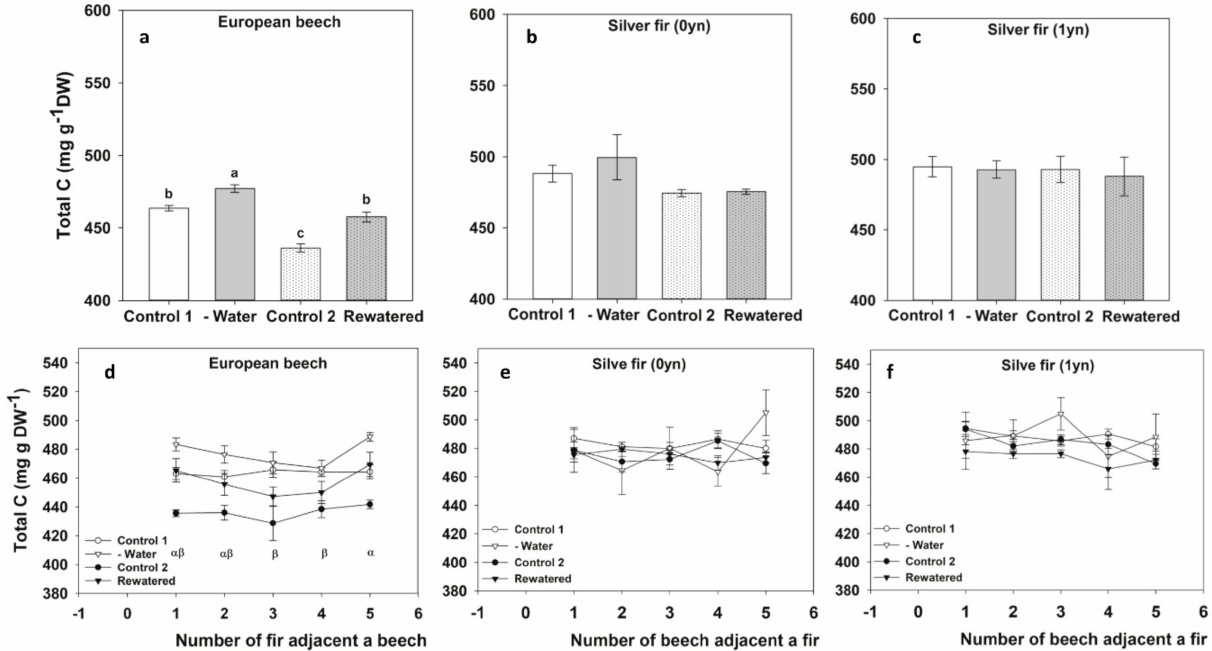
Figure 4. Foliar total C contents of beech ( F. sylvatica L.) and silver fir ( A. alba Mill.) seedlings. 0yn, current − year needles; 1yn, one − year needles. Significant differences between controls and treatments are indicated by different letters ( p ≤ 0.05; n = 80, ( a − c )), effect of the number of neighbouring trees (( d − f ), n = 5 − 30). Values shown are means ±